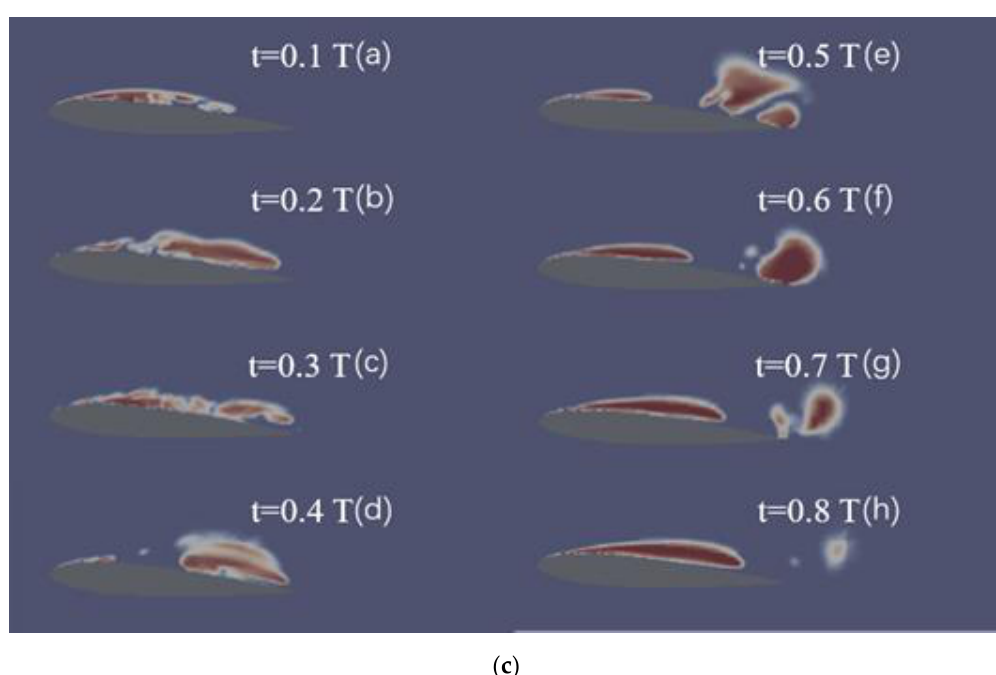
Figure 7. Change of cavitation morphology with different turbulence models at a 4-degree angle of attack. ( a ) Simulation of cavitation with SST k- ω turbulence model. ( b ) Simulation of cavitation with modified SST k- ω turbulence model. ( c ) Simulation of cavitation with the Smagorinsky turbulence model.